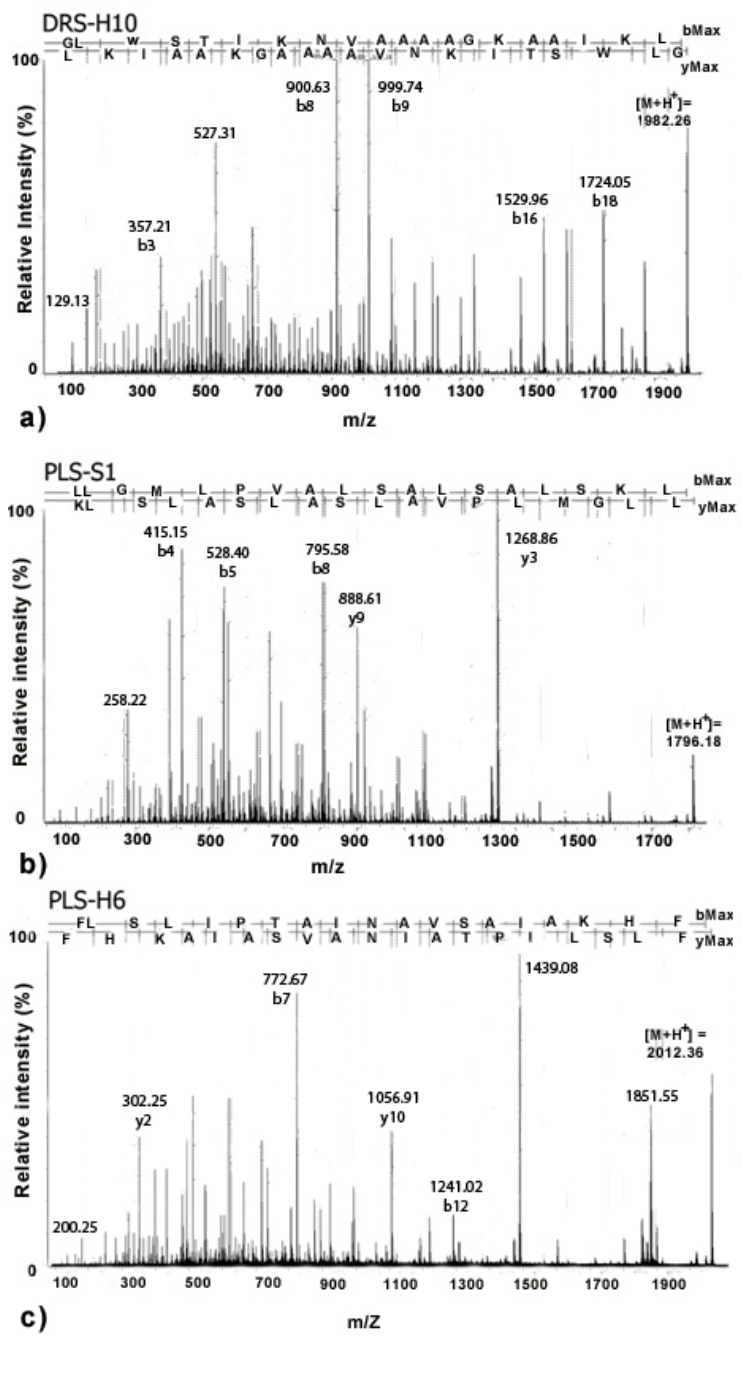
Figure 2. De novo sequencing of peptides on the skin secretion of P. nordestina (DRS-H10 ( a ), PLS-S1 ( b ), PLS-H6 ( c ), and PLS-H8b ( d )). The observed